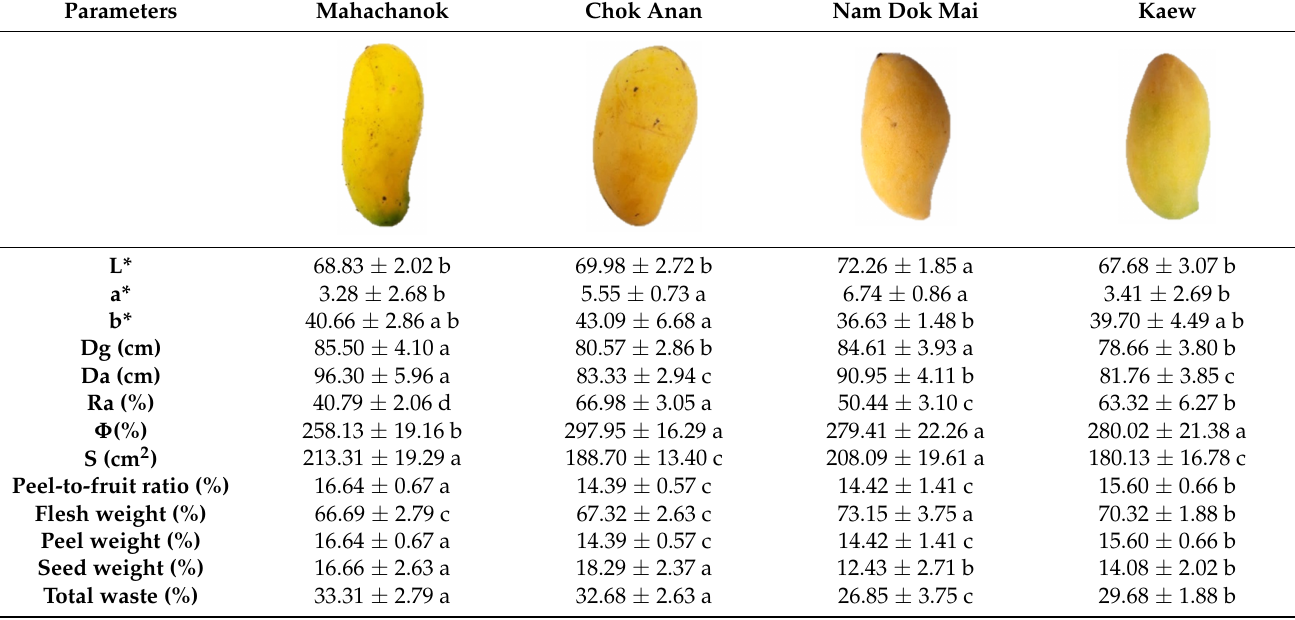
Table 1. Physical characteristics of different mango